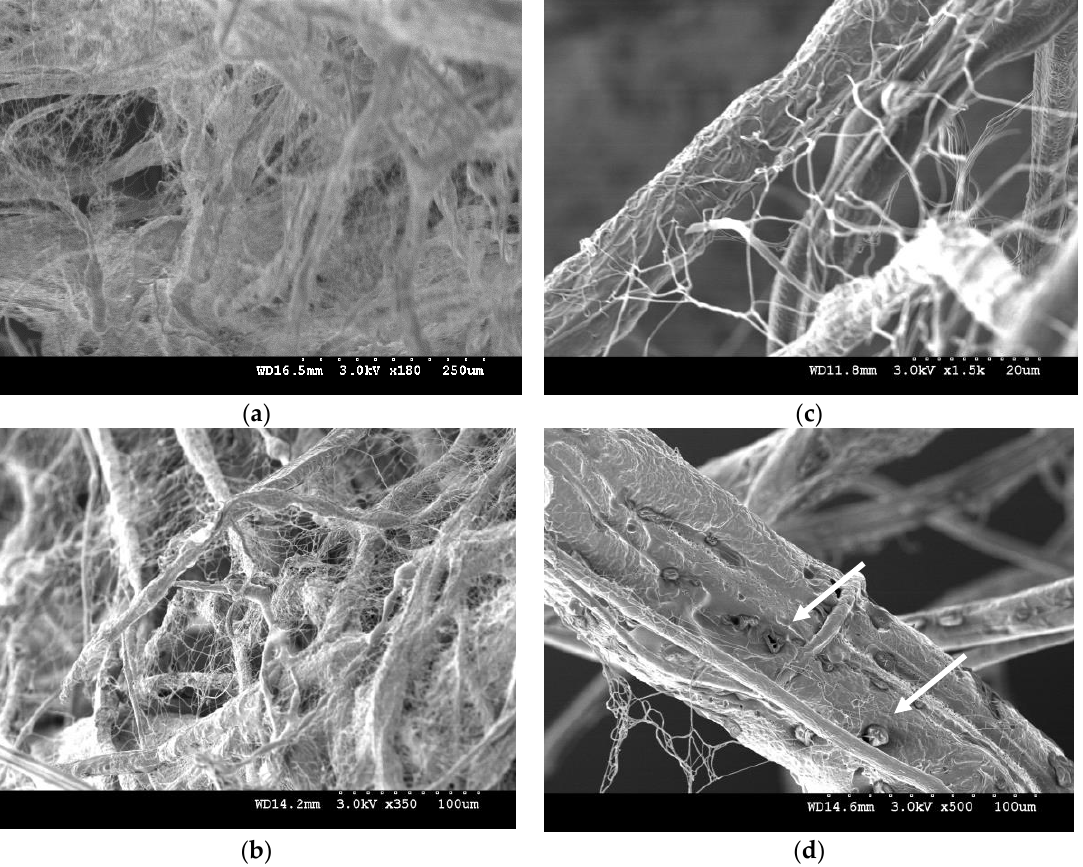
Figure 5. The morphology of bimodal fibers to predict the self-assembly mechanism of 3D fiber stack fabricated at 12 kV-applied voltage; spatial orientation of the 3D macrostructure: ( a ) ×180 ( b ) ×350 ( c ) ×1500 ( d ) Nanofibers from the core solution are likely to pass through weak spots of polymer jet from the shell solution while the solvent evaporates away; this can be shown by the holes (pointed by the white arrows) that remained on the surface of the microfibers of collagen graft copolymer.